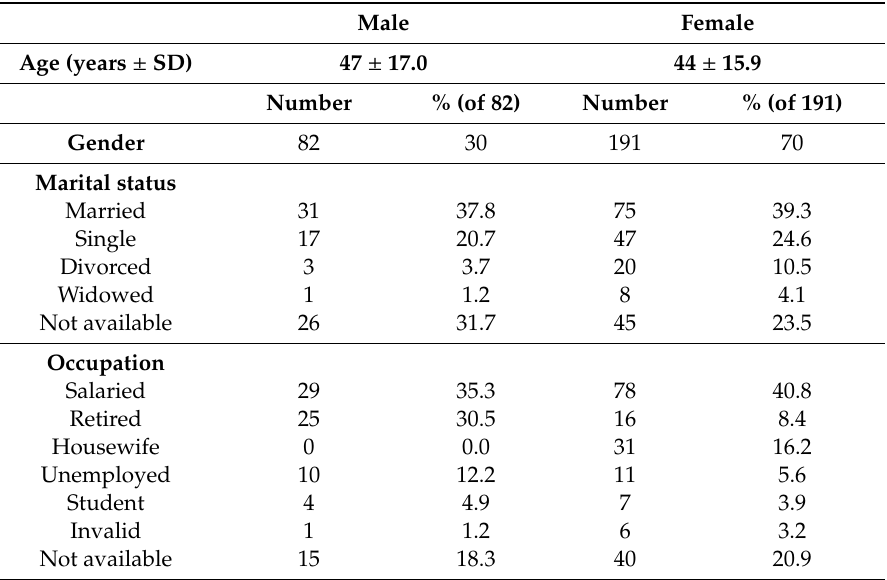
Table 1. Socio-demographic characteristics of the